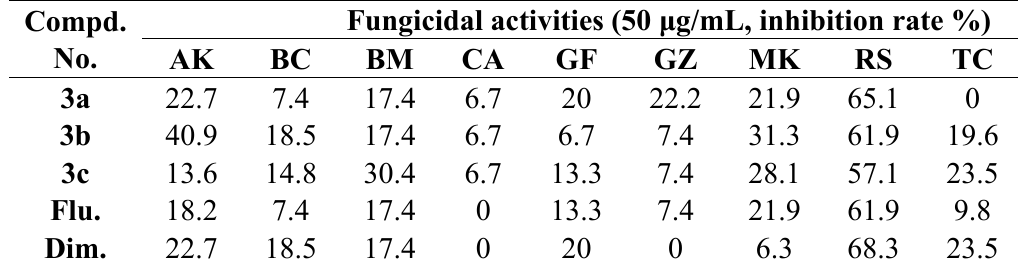
Table 2. The antifungal activities of compounds 3 .